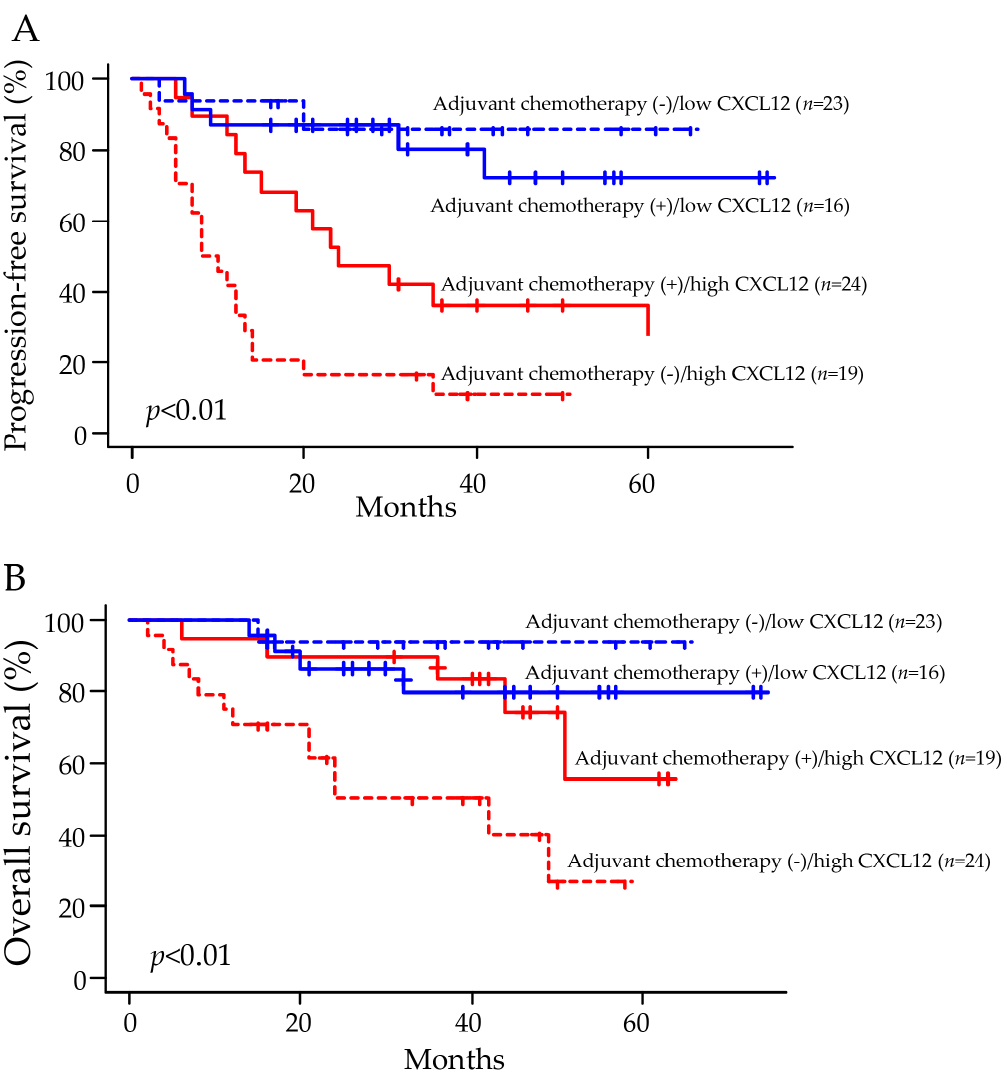
Figure 5. The progression-free survival and overall survival significantly improved in patients with high tumor CXCL12 expression receiving adjuvant chemotherapy. ( A , B ) Among patients with tumors showing high CXCL12 expression, the progression-free survival, and overall survival were significantly different between patients with and without adjuvant chemotherapy. Among patients with tumors showing low CXCL12 expression, the progression-free survival and overall survival were not significantly different between patients with and without adjuvant chemotherapy. The Kaplan–Meier method was used to illustrate the data.